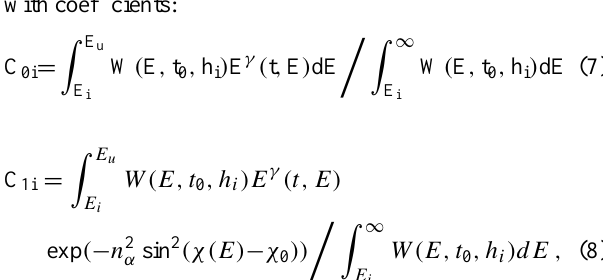
Figure 6 Fig. 7. Variation of the power law index (exponent) in isotropic Fig. 6. Behavior of the minimal, maximal, isotropic and mean (diamonds) and anisotropic (circles) fluxes of solar cosmic rays of 1GeV energy at the beginning of the event. Here and in succeeding figures Pfu means the number of particles per s.cm 2 .sr